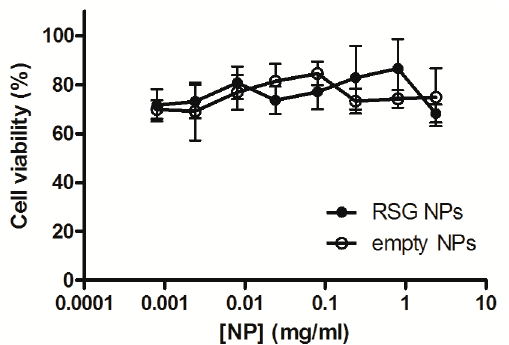
Figure 3. RAW264.7 cells’ viability after 24 h incubation with RSG NPs and blank NPs at different concentrations.